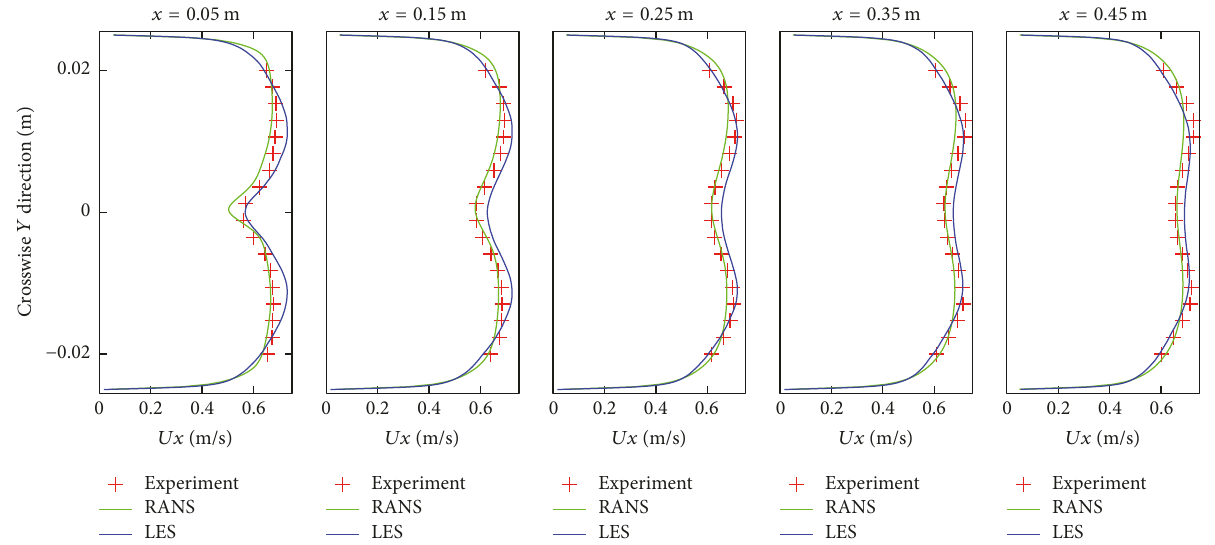
Figure 12: Streamwise velocity profiles at different locations for the two-liquid case.